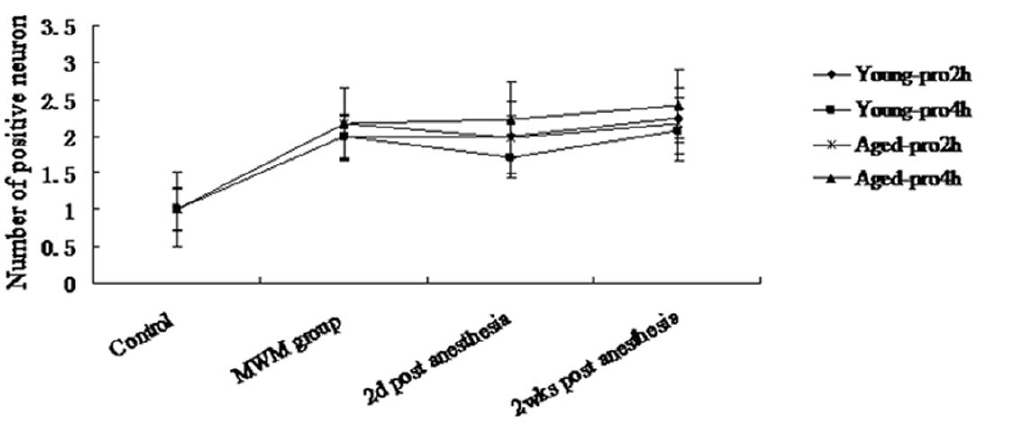
FIGURE 3 - Effect of propofol anesthesia on the expression of EGR1. Few EGR1 were seen in the hippocampal CA1 area of both young and aged rats. In MWM groups of all rats, number of EGR1 positive neurons in this area was significantly increased (P < 0.05), which was not affected by propofol exposure